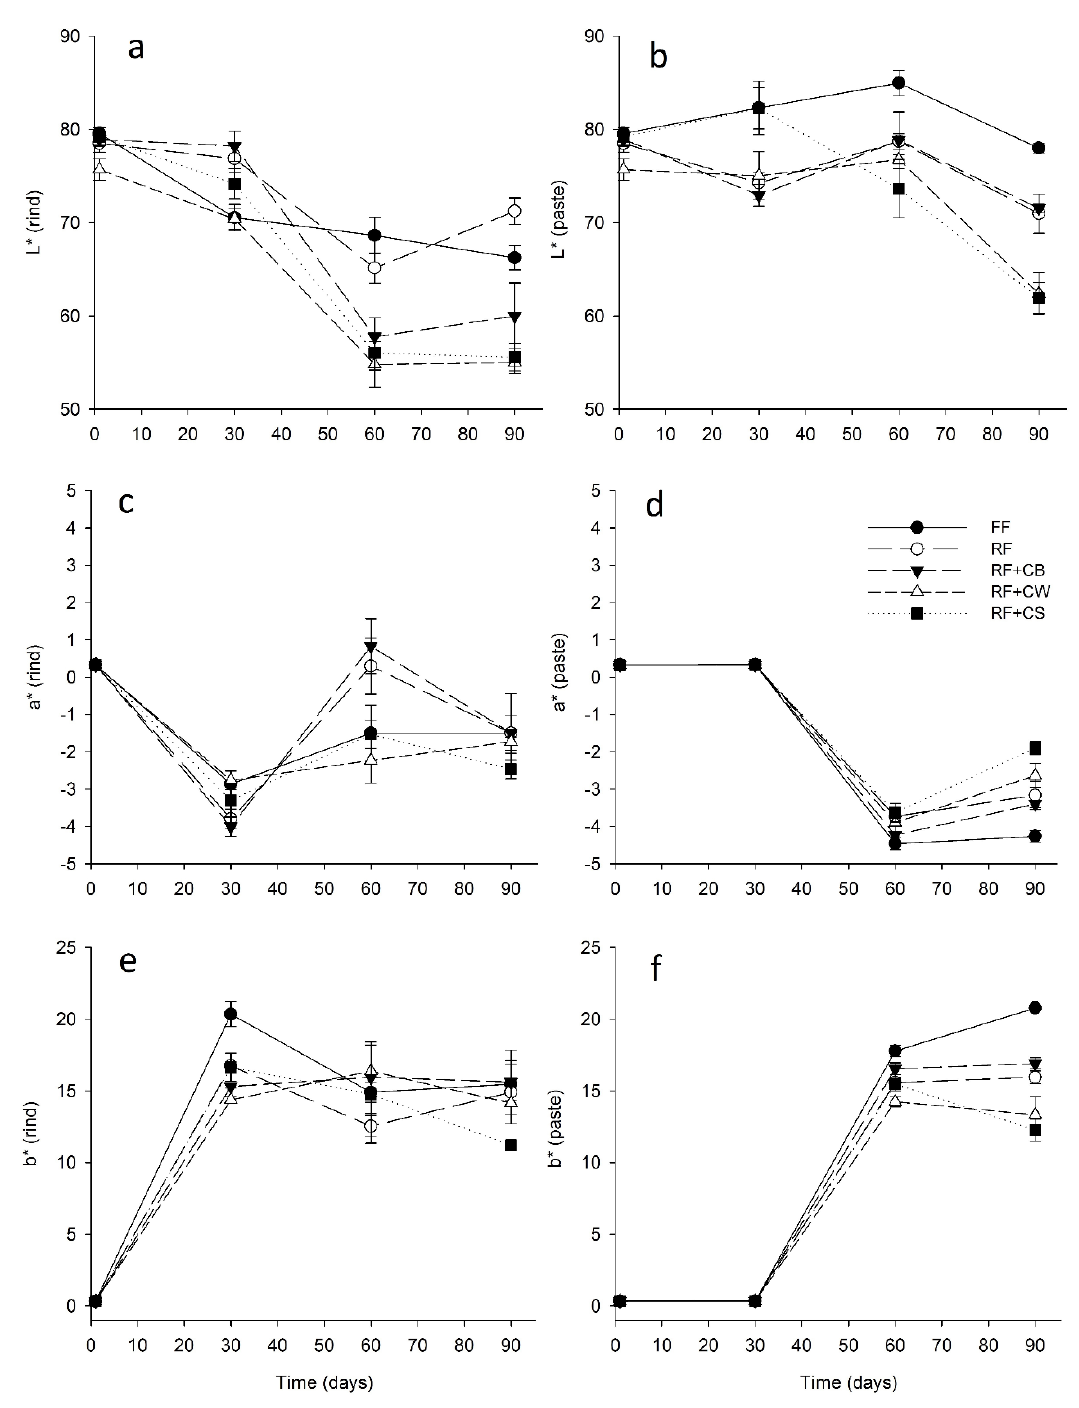
Figure 5. Colour parameters of the rind ( a , c , e ) and of the paste ( b , d , f ) of tested cheeses over ripening. (FF): full-fat; (RF): reduced-fat; (RF + CB): reduced-fat with concentrated buttermilk; (RF + CW): reduced-fat with concentrated whey; (RF + CS): reduced-fat with concentrated second cheese whey.